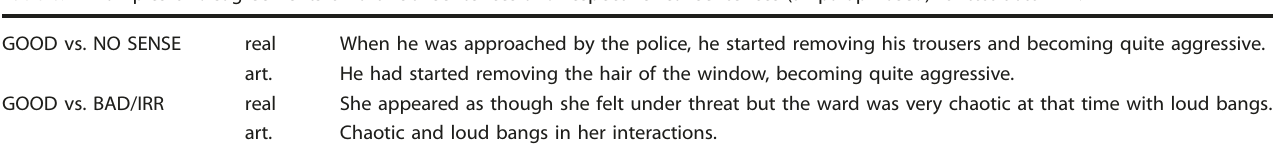
Table 6. Examples of disagreements on arti fi cial sentences and respective real sentences (all paraphrased) for test-class-mhr . GOOD vs. NO SENSE GOOD vs.